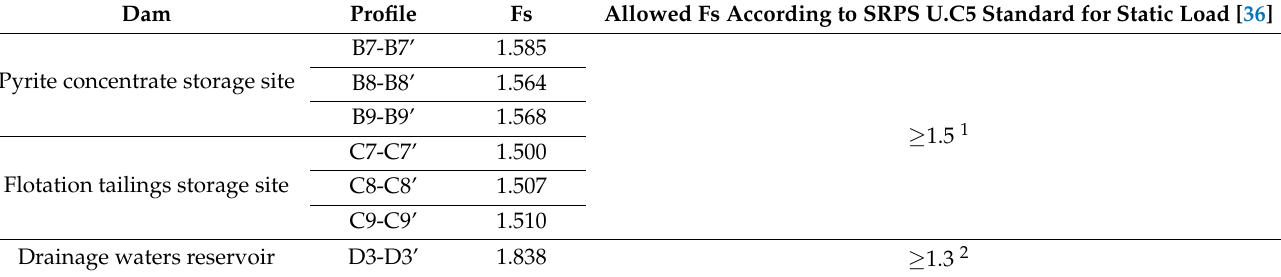
Figure 6. Results of stability analysis : ( a ) Position of the profiles used for stability analysis and ( b ) cross-sections of the dams [20]. Reproduced with permission from author and publisher Mining and Metallurgy Institute Bor (MMI Bor), Serbia Zijin Mining doo Bor, Detailed Mining Design—Mineral Processing and Disposal of Tailings and Pyrite Concentrate from Cukaru Peki Deposit—Upper Zone, Bor, 2020. Table 5. The calculated static F s [20]. Reproduced with permission from author and publisher Mining and Metallurgy Institute Bor (MMI Bor), Serbia Zijin Mining doo Bor, Detailed Mining Design—Mineral Processing and Disposal of Tailings and Pyrite Concentrate from Cukaru Peki Deposit—Upper Zone, Bor, 2020.